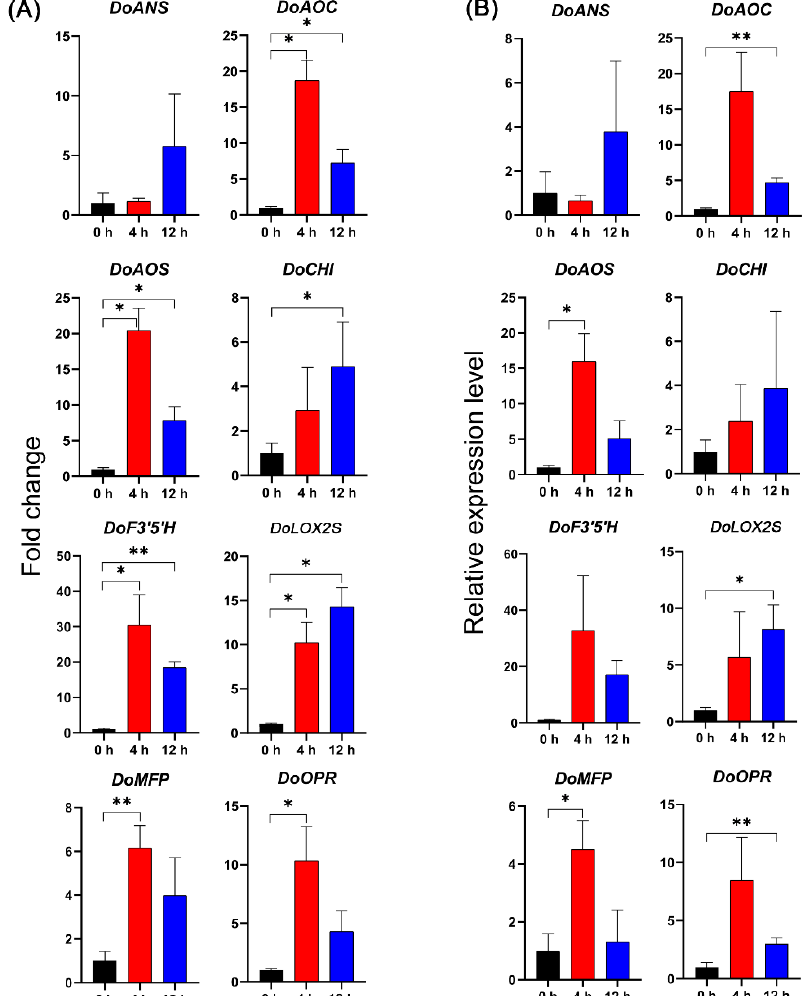
Figure 2. qRT-PCR confirmation of expression profiles obtained by RNA-Seq transcriptome analysis at different times after salt treatment. Fold-change in transcript abundance obtained by both qRT-PCR and RNA-Seq are presented on the same graph for eight representative encoding genes. Column ( A ) shows the fold-change in the Fragments Per Kilobase of transcript sequence per Millions mapped reads (FPKM) value obtained by RNA-Seq, and column ( B ) shows the fold-change in the expression determined by qRT-PCR. DoANS, DoAOC, DoAOS, DoCHI, DoF3′5′H, DoLOX2S, DoMFP, and DoOPR are anthocyanin synthase, allene oxide cyclase, allene oxide synthase, chalcone isomerase, flavonoid 3′,5′-hydroxylase, lipoxygenase, peroxisomal fatty acid beta-oxidation multifunctional protein, and 12-oxophytodienoate reductase, respectively, in D. officinale . Data represent means and SDs. Statistical significance was calculated using GraphPad Prism 8 (Version 8.0.2, GraphPad Software, La Jolla, CA, USA). * p < 0.05; ** p < 0.01.